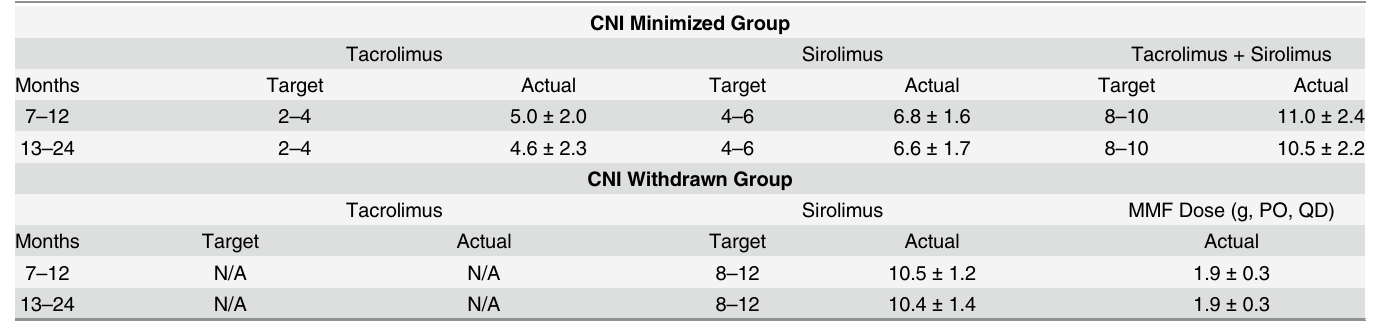
Table 3. Targeted and Actual Blood Levels of tacrolimus and sirolimus